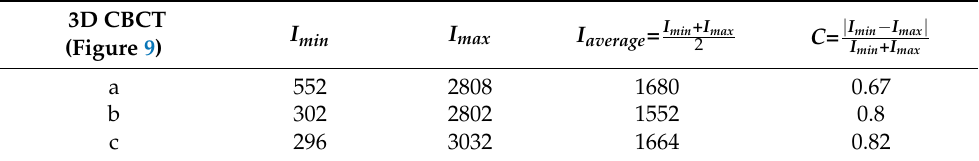
Table 4. Highest, lowest, and average values of pixel intensity I , as well as C , all related to the optimization process presented in Figure